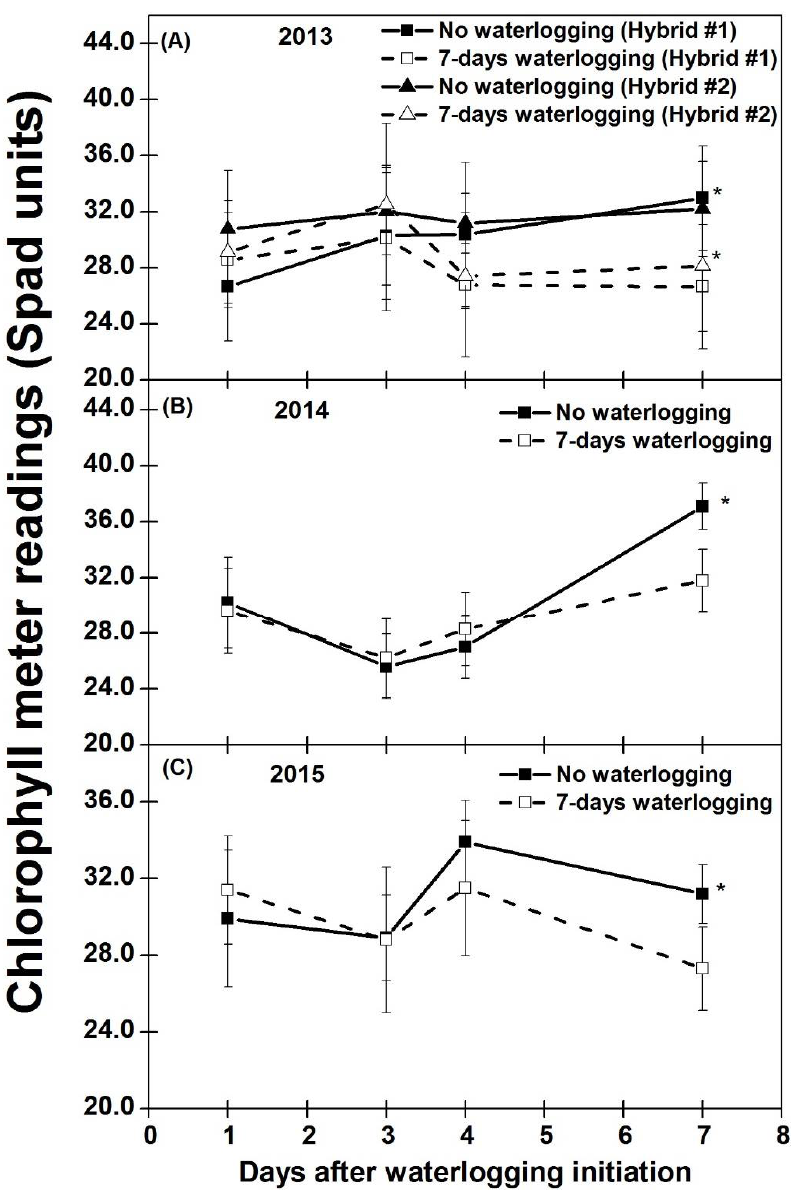
Figure 4. Changes in chlorophyll meter readings taken during the waterlogging events in 2013 ( A ), 2014 ( B ) and 2015 ( C ) growing season. Vertical bars indicate ± 1 standard deviation. *